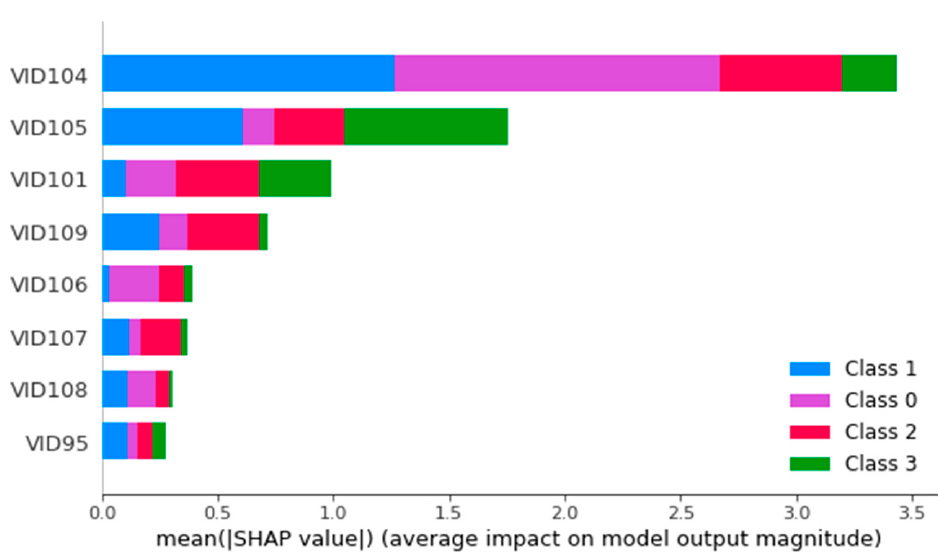
Figure 5. SHAP values with LightGBM.